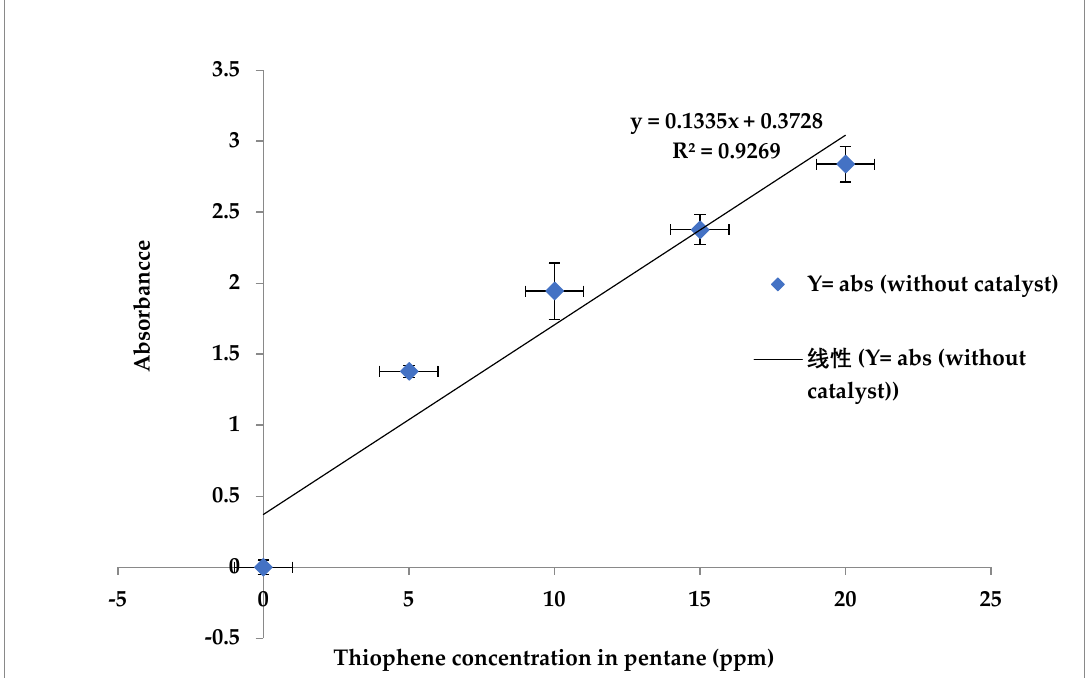
Figure 1. Calibration curve for thiophene concentration in pentane.